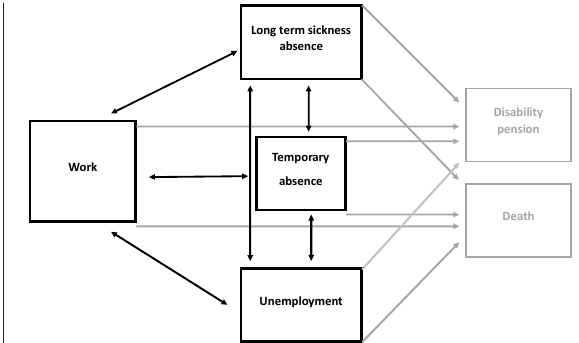
Figure 1. Overview of working life estimation: 12 recurrent transitions between work, sick, unemployment, or temporary absence (transient states in black, 8 permanent states in